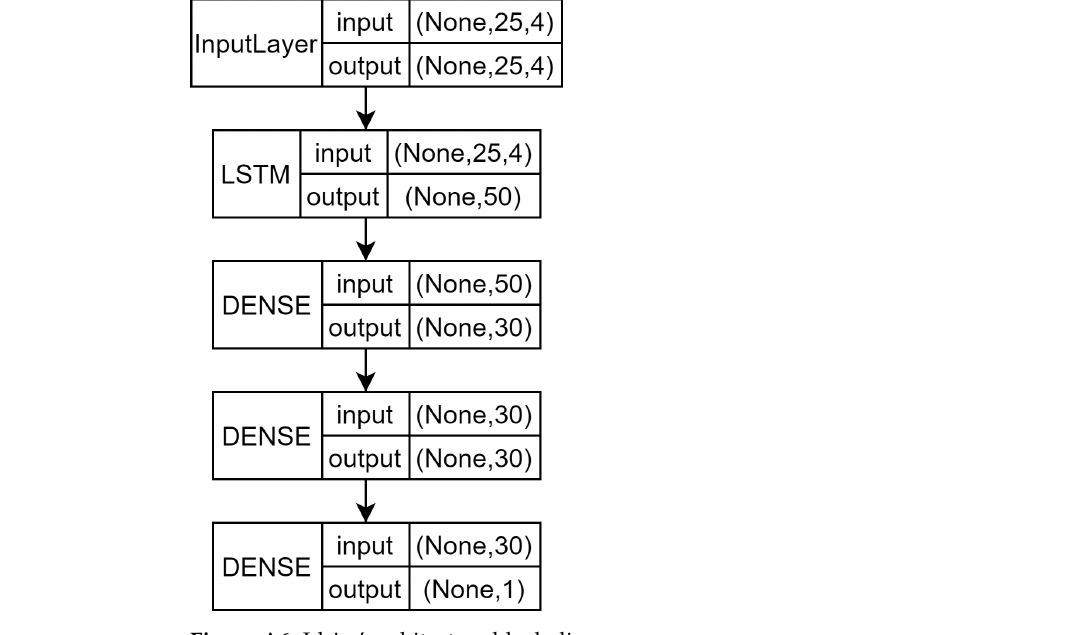
Figure A6. Idriss’ architecture block diagram.